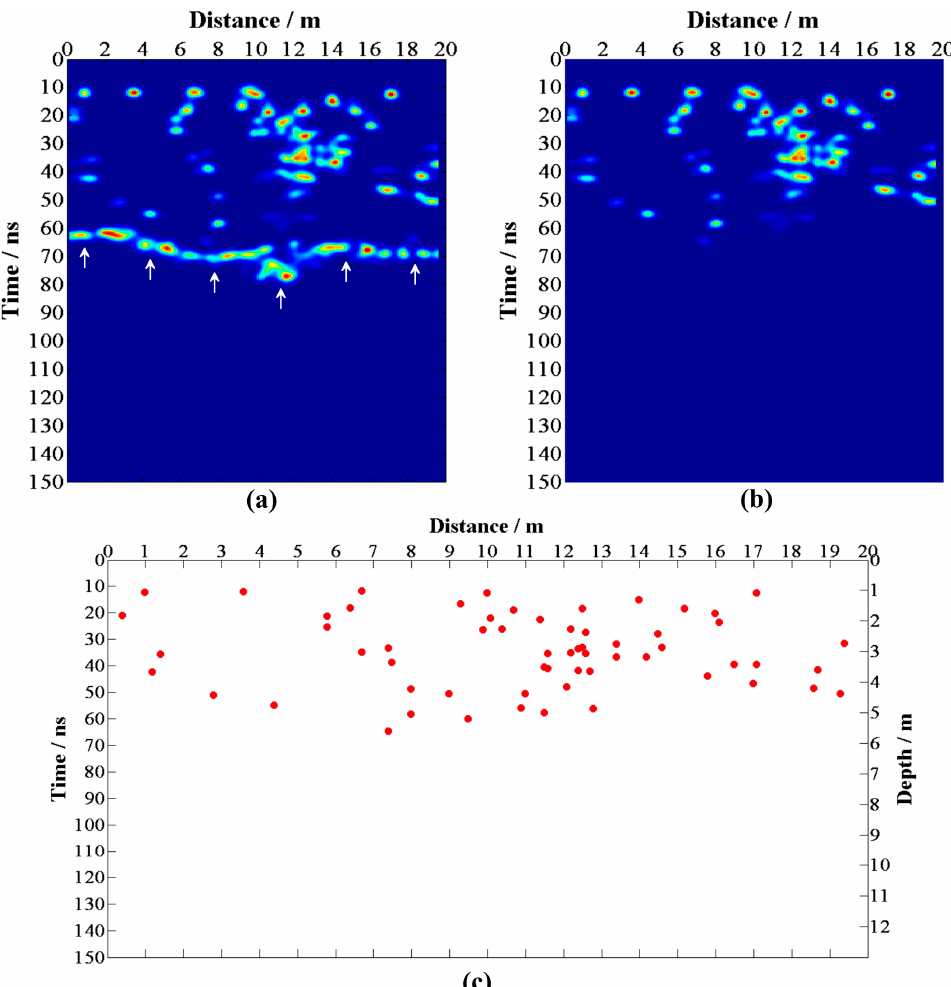
Figure 8. ( a ) Local similarity spectrum in two filtered datasets (Figure 6), ( b ) diffraction section of ( a ), ( c ) the result of rock positioning